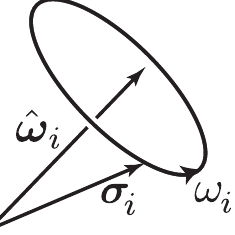
FIG. 3. σ precesses around ˆ ω i for K ¼ 0 with D ¼ 3